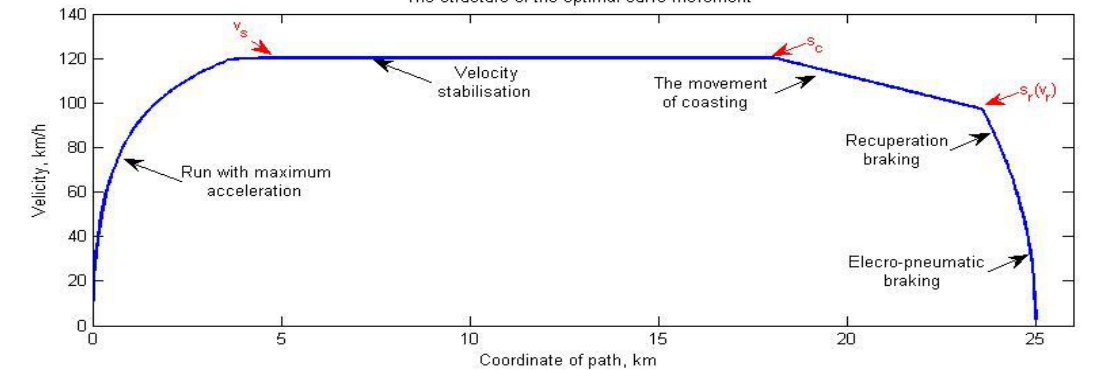
v - velocity of stabilization; Figure 1. The structure of the optimal trajectory of the train movement: s s - coordinate of start coasting; )( vs - coordinate or velocity of start recuperation braking c rr In this case the ATO is constructed as a two-loop feedback system with elements of prediction and